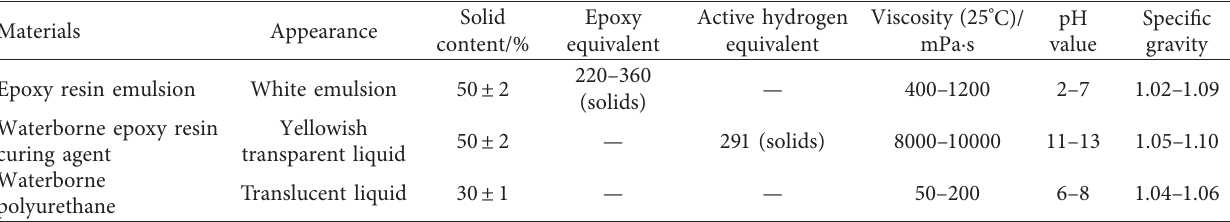
Table 2: The main technical indexes of polymer modifier.